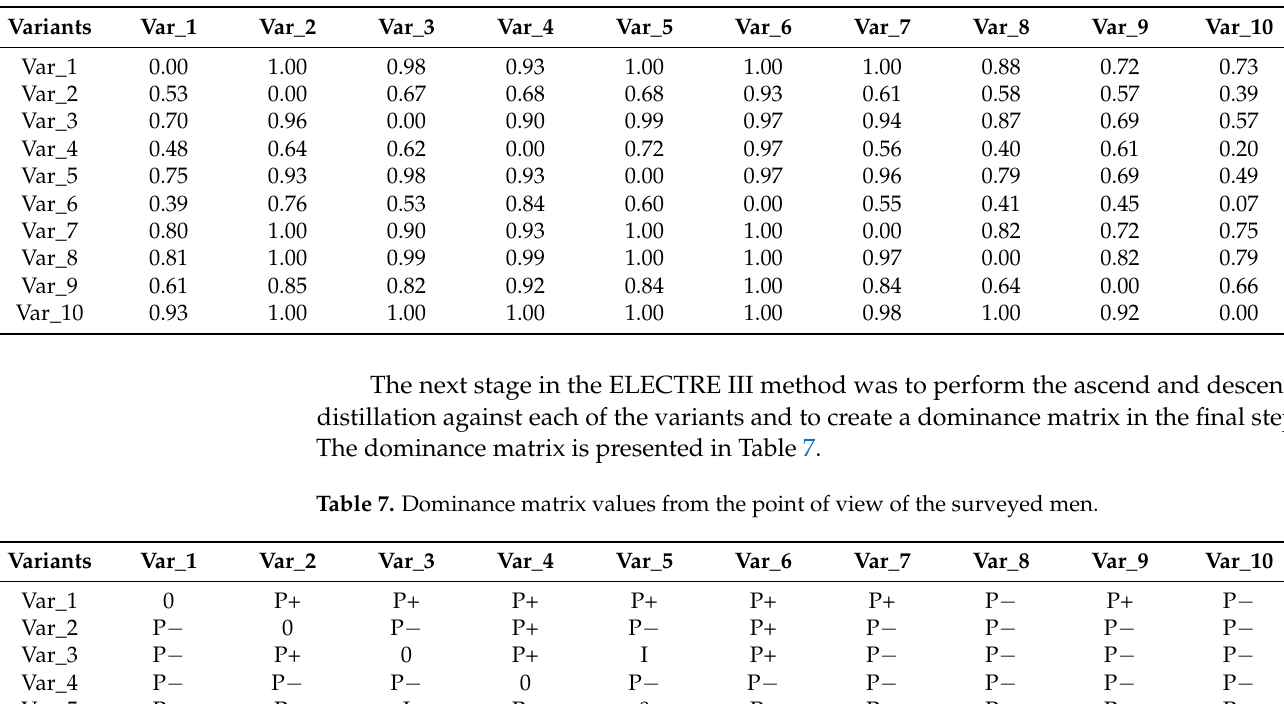
Table 6. Concordance matrix values from the point of view of the surveyed men.